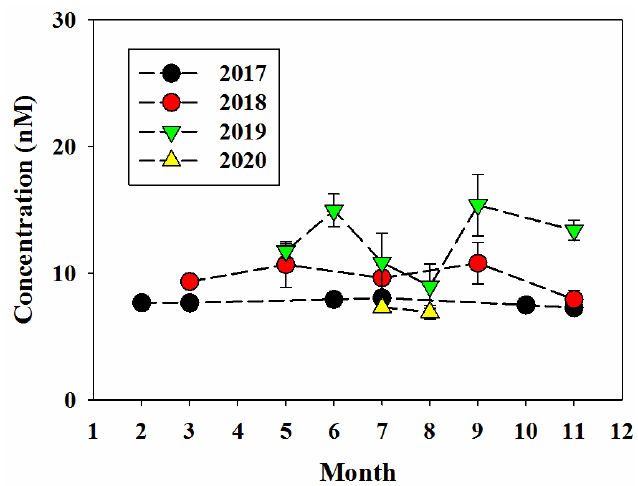
Figure 6. The change in dissolved reactive iron (DrFe) concentrations (unit: nM) over four years